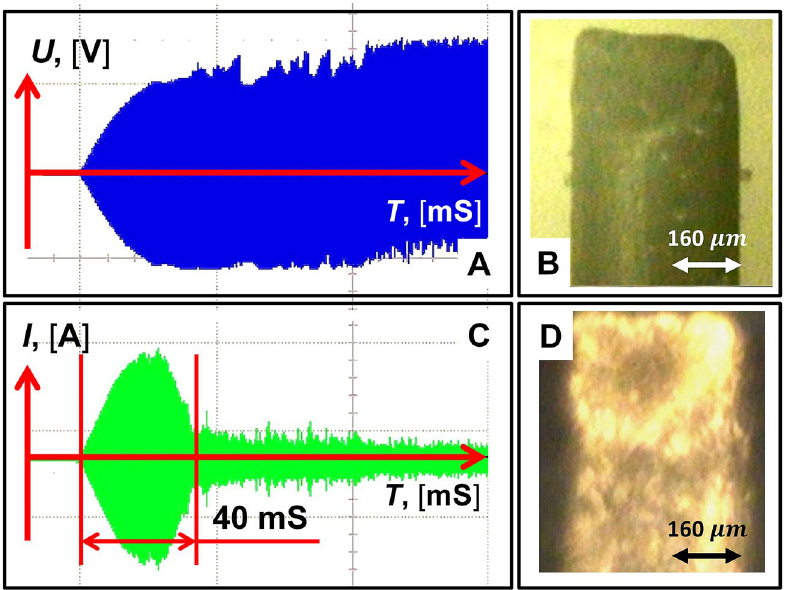
Figure 2. The voltage ( A ) and current ( C ) flowing through the electrode near the plasma discharge ignition threshold are shown. The characteristic time of enveloping the electrode with plasma is approximately 20 ms (half of the current band). Time-integrated image of a tungsten electrode with a diameter of 500 µm over a period of 20 ms: no plasma ( B ) and plasma on the electrode ( D